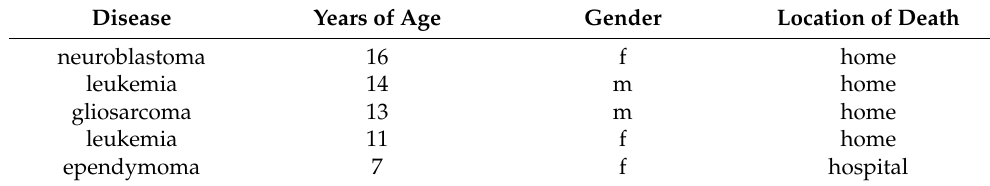
Table 1. Children represented. Disease Years of Age Gender Location of